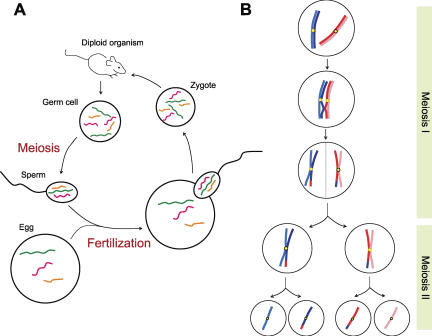
Chromosome Cycle of Meiosis and Sexual Reproduction(A) Simplified reproductive cycle of sexual organisms. Chromosomes are represented as colored lines, with two of each color to represent the maternal and paternal copies of each. During meiosis, the number of chromosomes is reduced by half to generate gametes (e.g., sperm and eggs). Diploidy is restored upon fertilization.(B) Two consecutive cell divisions in meiosis. In meiosis I, homologous chromosomes recombine and exchange genetic information before they separate from one another. In meiosis II, sister chromatids separate.